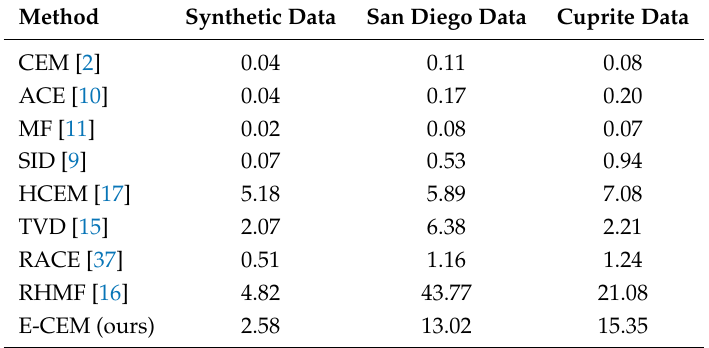
Table 5. The computational time (second) of different algorithms on synthetic data, AVIRIS San diego Data and AVIRIS Cuprite